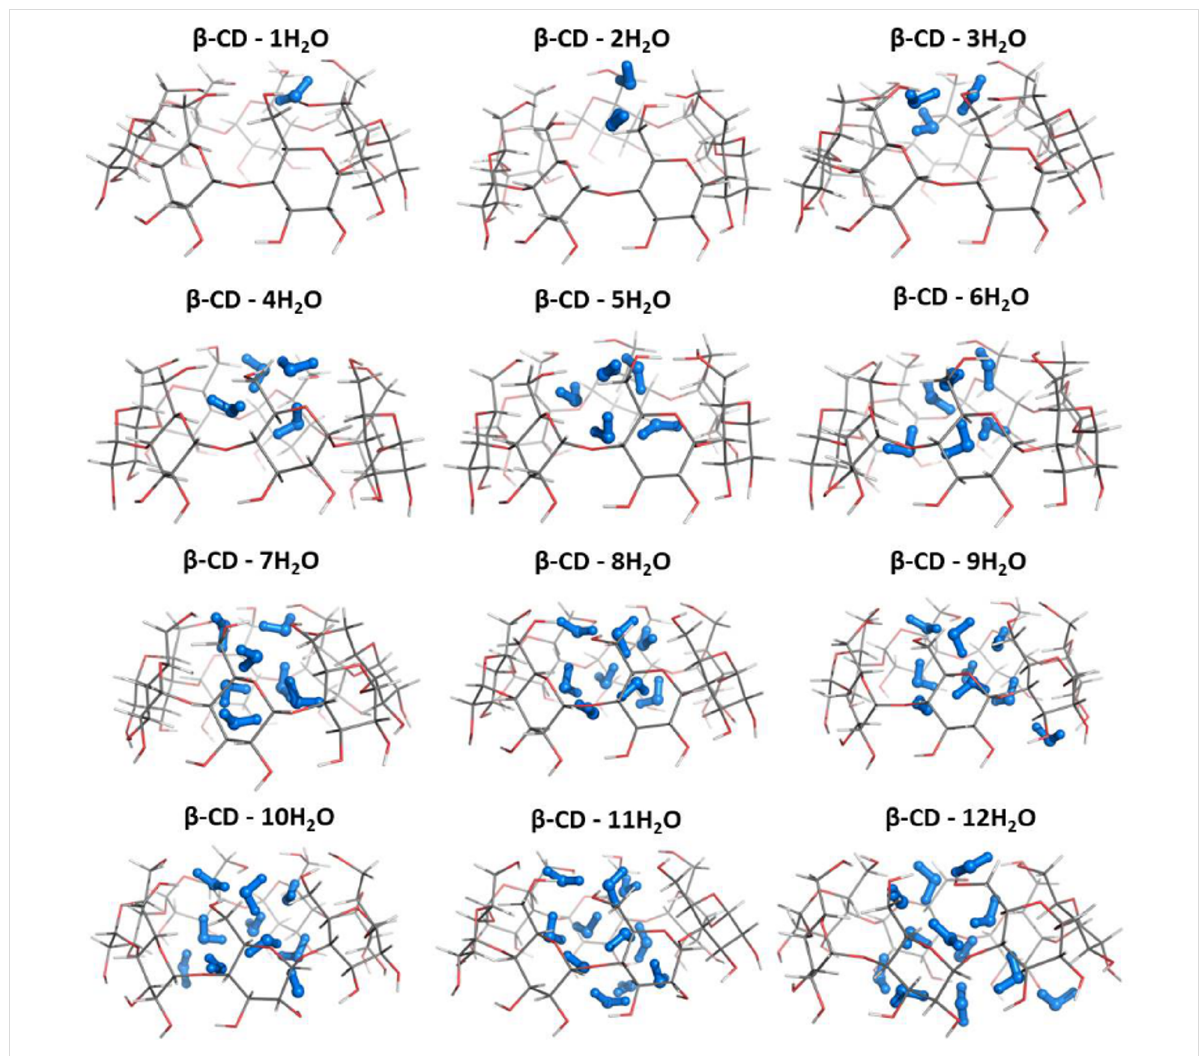
Figure 3: M062X/6-31G(d,p) optimized structures of the most stable ( a structures from Figure 2) β -CD– n H 2 O complexes ( n = 1–12).